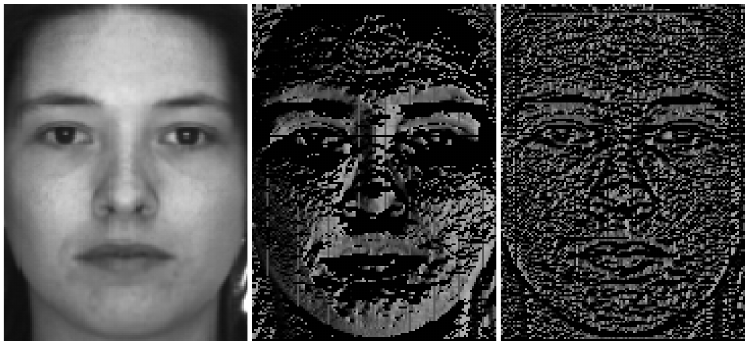
Figure 2. Original face image and its gradient orientations of the first and second orders,